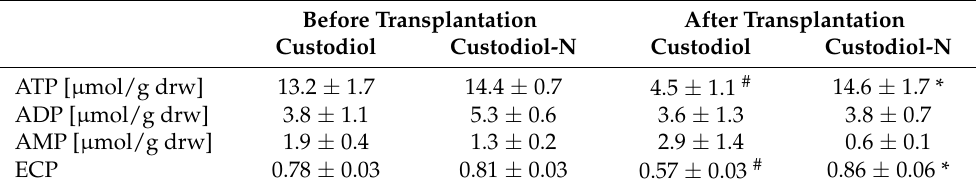
Table 3. High-energy phosphates (Series 1: 4 h conservation time).